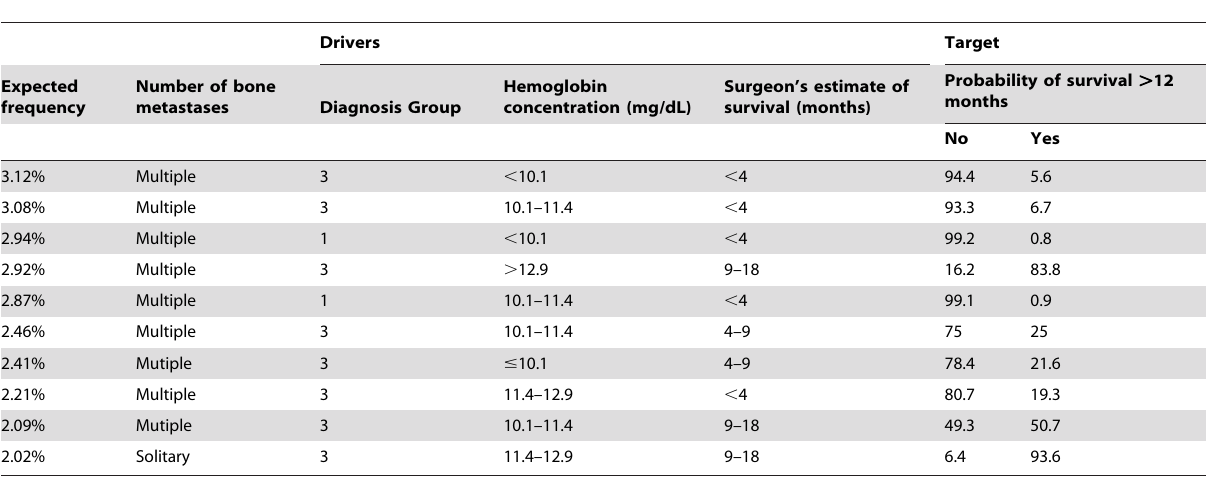
Table 3. Posterior estimates of survival at 12 months (10 most frequent cases).